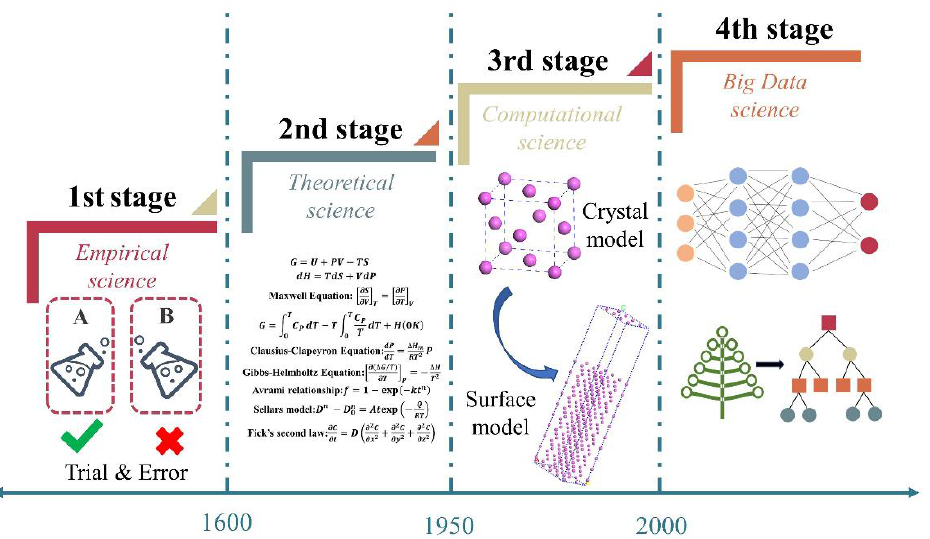
Figure 17. Development in the materials science divided into four stages: Empirical, theoretical, computational, and big-data.